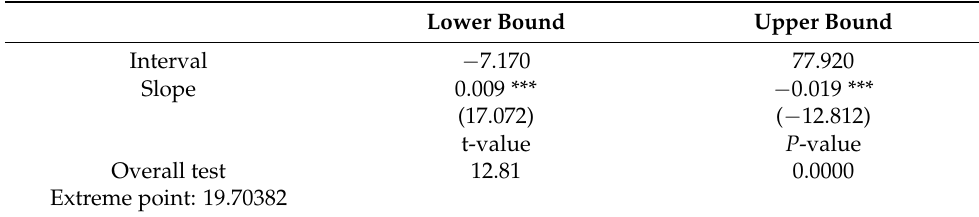
Table 4. Test for the U-shaped